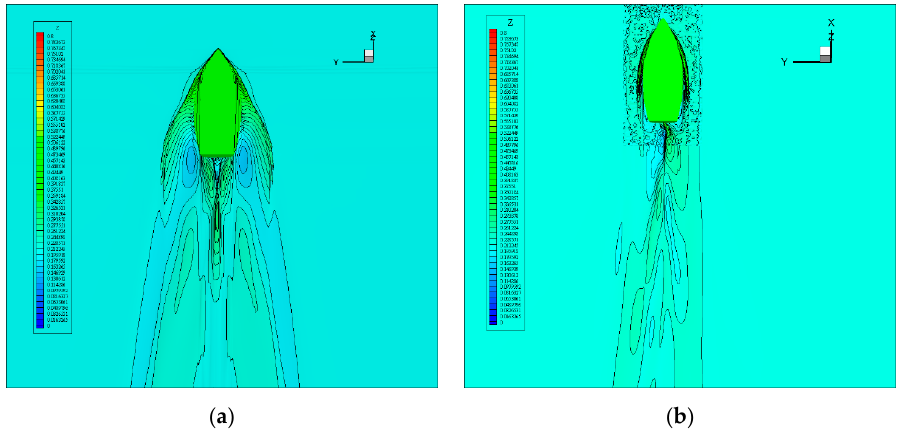
Figure 4. The wake profile of 470 Sailing: ( a ) naked hull and ( b ) hull-rudder assembly.